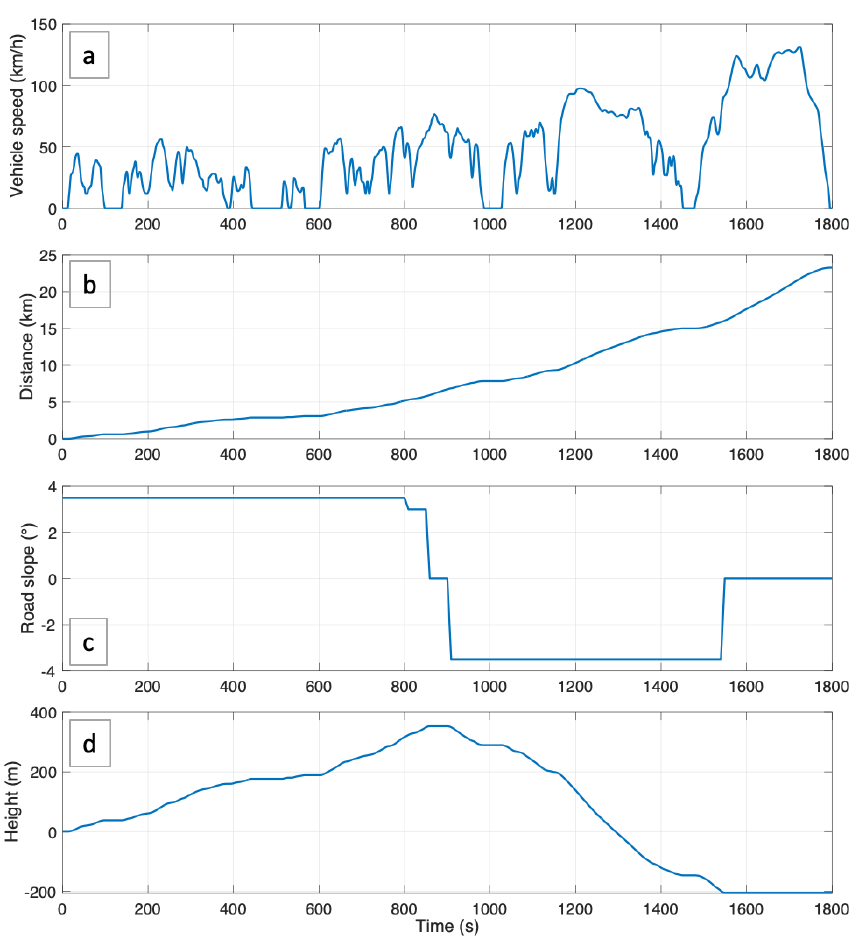
Figure 4. Desired speed ( a ), traveled distance ( b ), considered road slope ( c ) and related traveled height ( d ) for the accounted WLTC cycle.